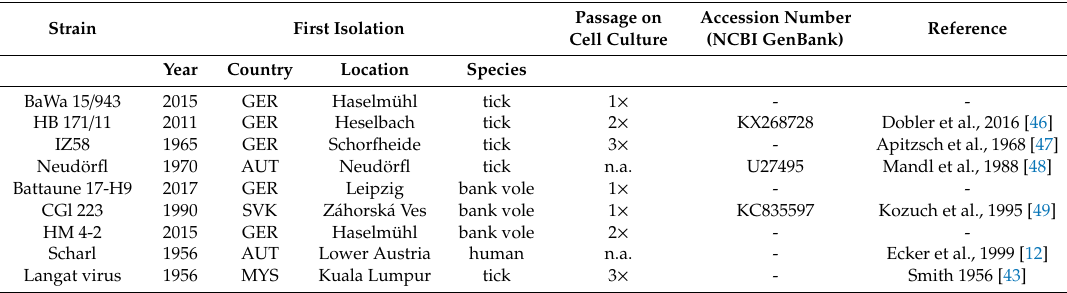
Table 1. Virus strains used in the present study, including information on the initial isolation (year, place,